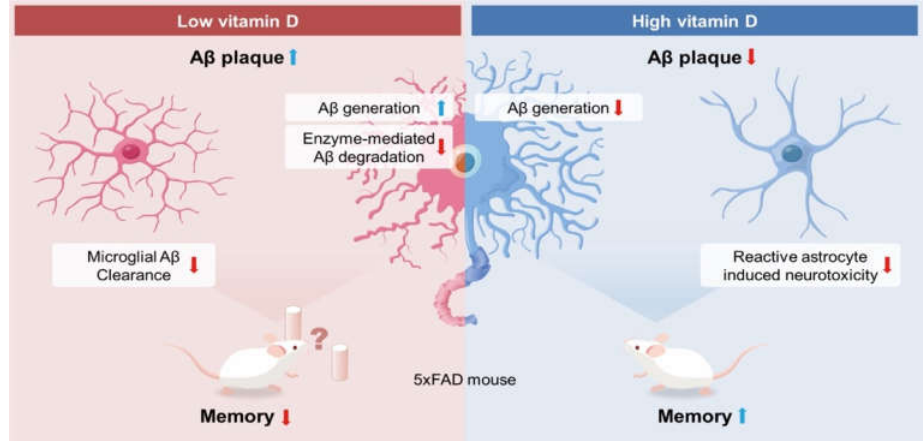
Figure 7. Possible mechanism for the observed effects of vitamin D on Alzheimer’s disease. Based on our results, low vitamin D induced increased A β generation and reduced enzyme-mediated A β degradation. Moreover, vitamin D deficiency attenuated the microglial clearance of A β , resulting in more A β load and memory impairment. On the other hand, according to the data, high vitamin D induced a lower A β load by reducing the A β generation and neurotoxic reactive astrocytes. In addition, vitamin D restored the visuospatial memory function in 5xFAD